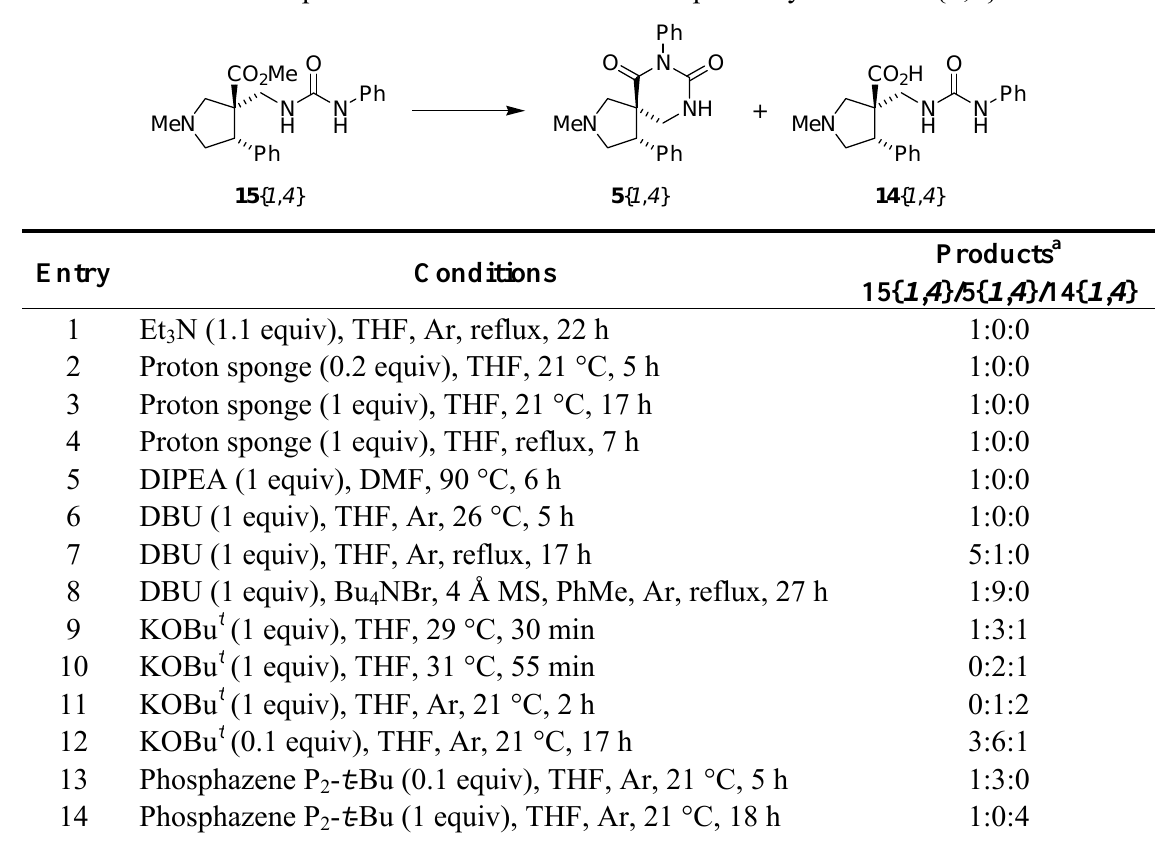
Table 6. Optimization of the formation of spiro dihydrouracil 5 { 1 , 4